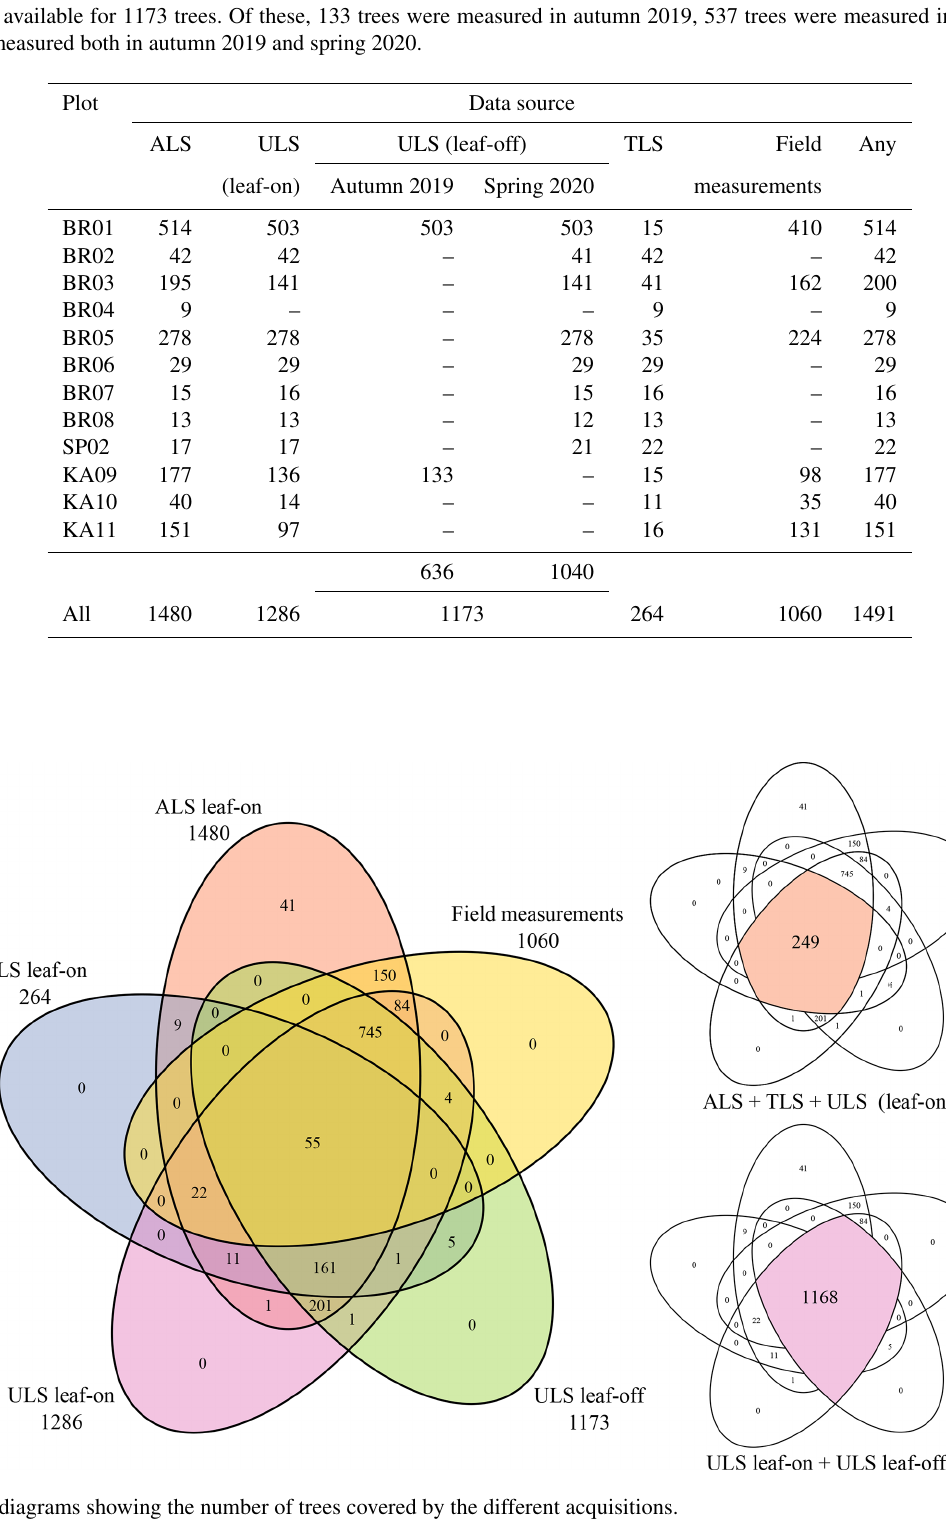
https://doi.org/10.5194/essd-14-2989-2022 Earth Syst. Sci. Data, 14, 2989–3012,